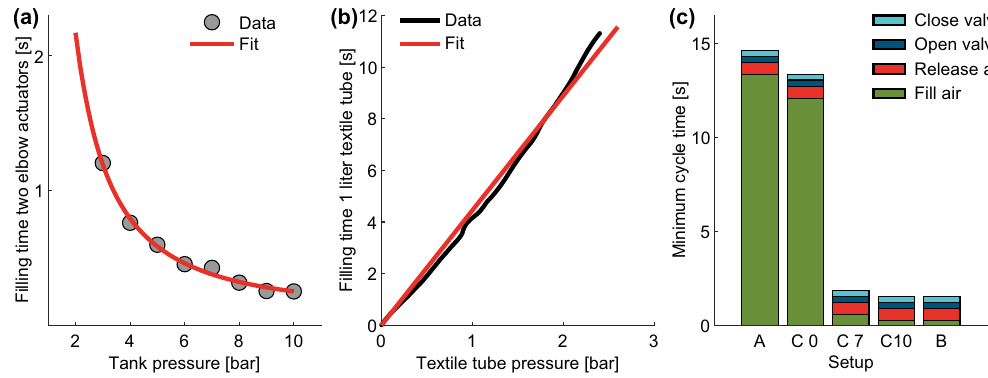
Figure 6. Exoskeleton operation dynamics including ( a ) the tank pressure to Carry filling time relationship, ( b ) the textile tube pressure (one liter) to mobile compressor filling time relationship, and ( c ) the Carry cycle times with respect to the supply mode of Setup A (compressor), C0 (tank almost empty), C7 (tank refilled to 7 bar), C10, and B (both tank above 10